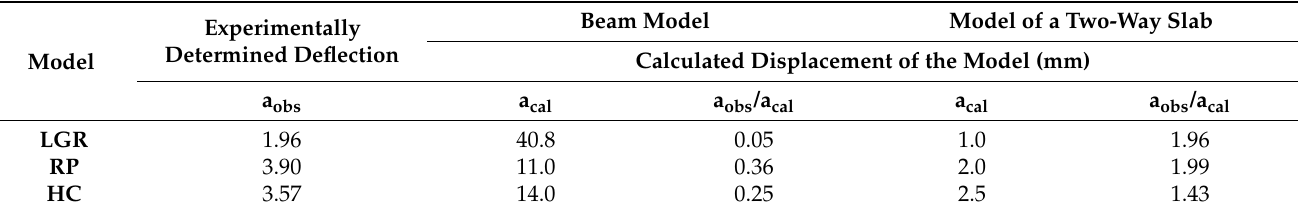
Table 7. Comparison of results from tests and calculations for long-term loading. Beam Model Model of a Two-Way Slab Experimentally Determined Deflection Calculated Displacement of the Model Model